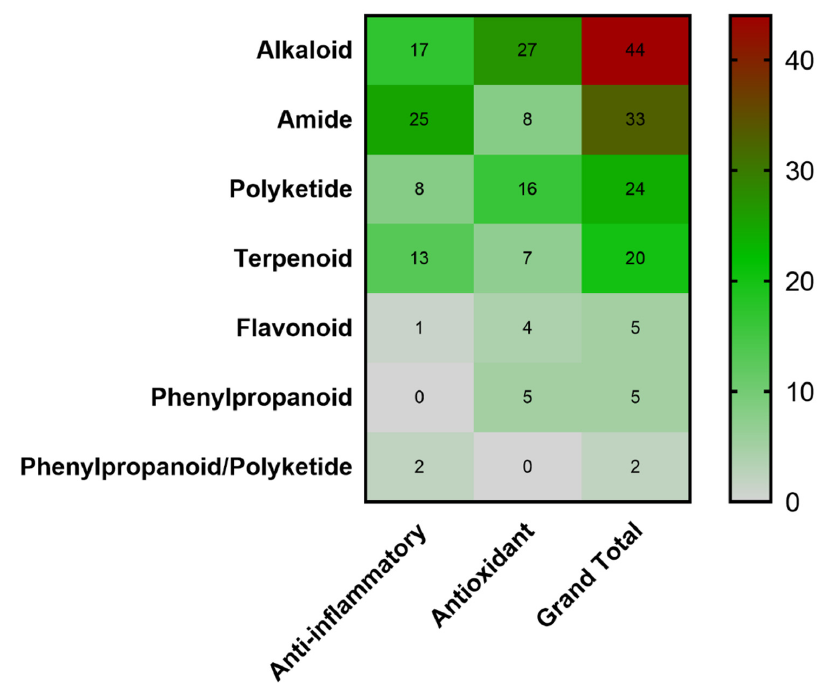
Figure 8. Heatmap analysis of Streptomyces -derived compound library. The compounds were classified as alkaloids, amides, polyketides, terpenoids, flavonoids, phenylpropanoids and mixed phenylpropanoid/polyketide according to the biosynthetically based chemical structure. Inside each cell, the number of compounds in the given group is presented. The color bar represents the number of compounds, gray (minor values), green (middle values) and red (high values).